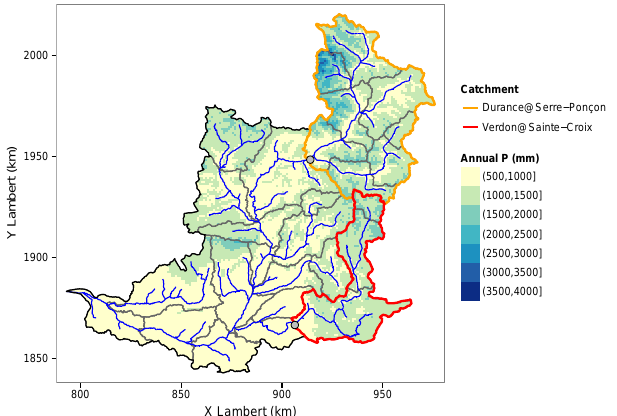
Figure 1. Delineation of the Durance basin and the two case study catchments drawn on the gridded map of the 1980–2009 mean annual precipitation from the SPAZM reanalysis (Gottardi et al., 2012). The coordinate system is the Lambert II Étendu con- formal conic projection (http://www.ign.fr/sites/all/files/geodesie_